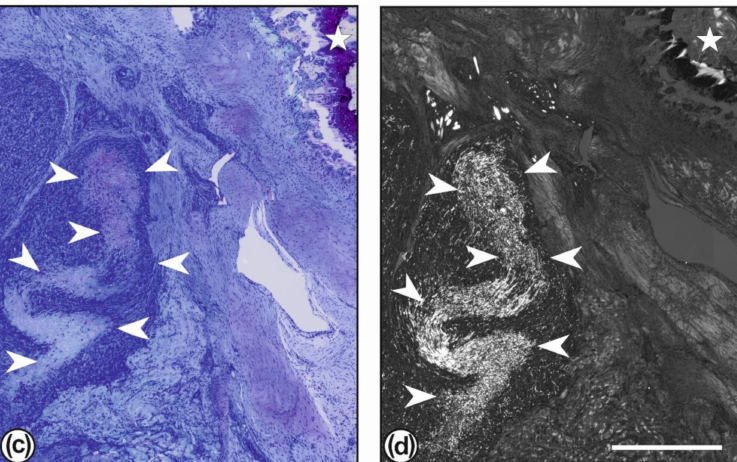
Figure 3. Toluidine blue staining ( a ) and polarisation optics ( b ) of the same section of a left shoulder with an implanted TGF– β 3–CS–g–PCL sca ff old. The white rectangles in ( a , b ) are shown in higher magnification in ( c , d ). The whole construct consists of humerus bone (white star), sca ff old (outlined by black or white dots), and the reattached tendon. In ( b ) it can be clearly seen that a healthy and normal tendon (marked by white arrows) is present only at some distance away from the surgical site. The area between consists mostly of newly formed granulation tissue and degraded original muscle and tendon tissue. In ( c , d ) the granulation tissue ensheathing the TGF– β 3–CS–g–PCL sca ff old is shown. The infiltration of the sca ff old with numerous cells can be seen, also the presence of areas with a still higher density of fibres and with only a few cells inside (marked by white arrowheads). Bar = 2000 µ m ( a , b ); 400 µ m ( c , d ).